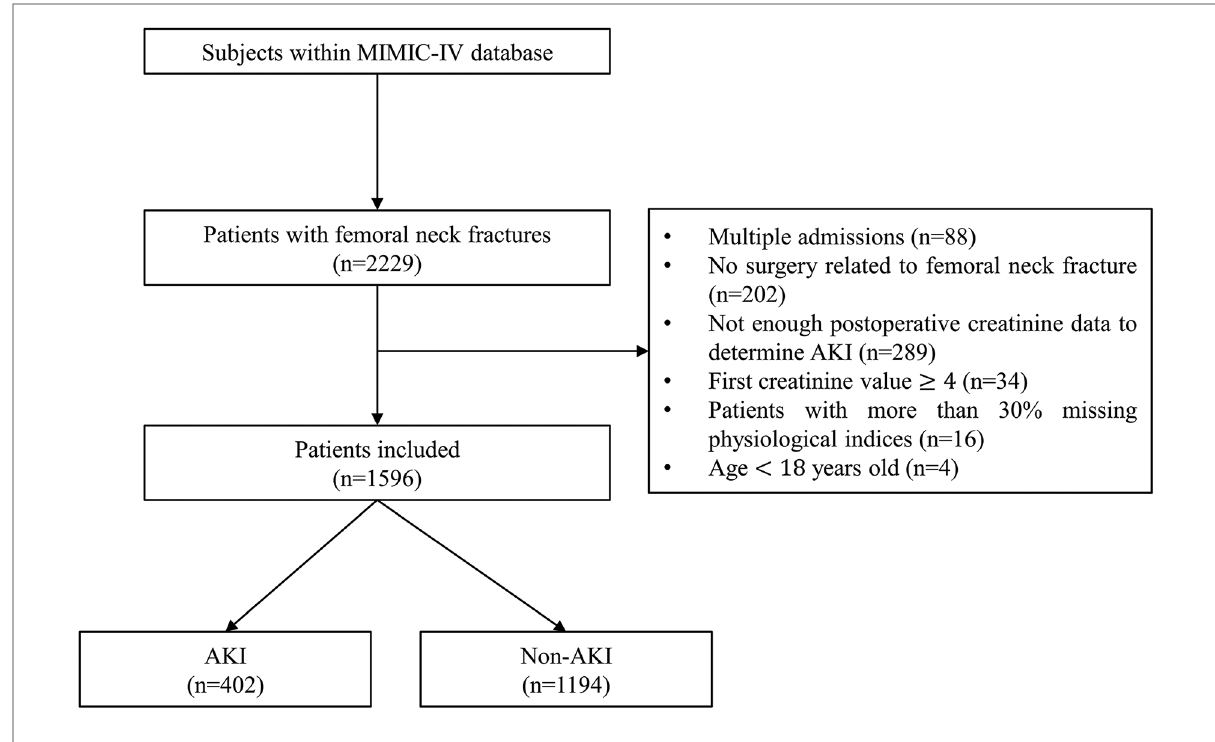
FIGURE 1 Flow chart of patient